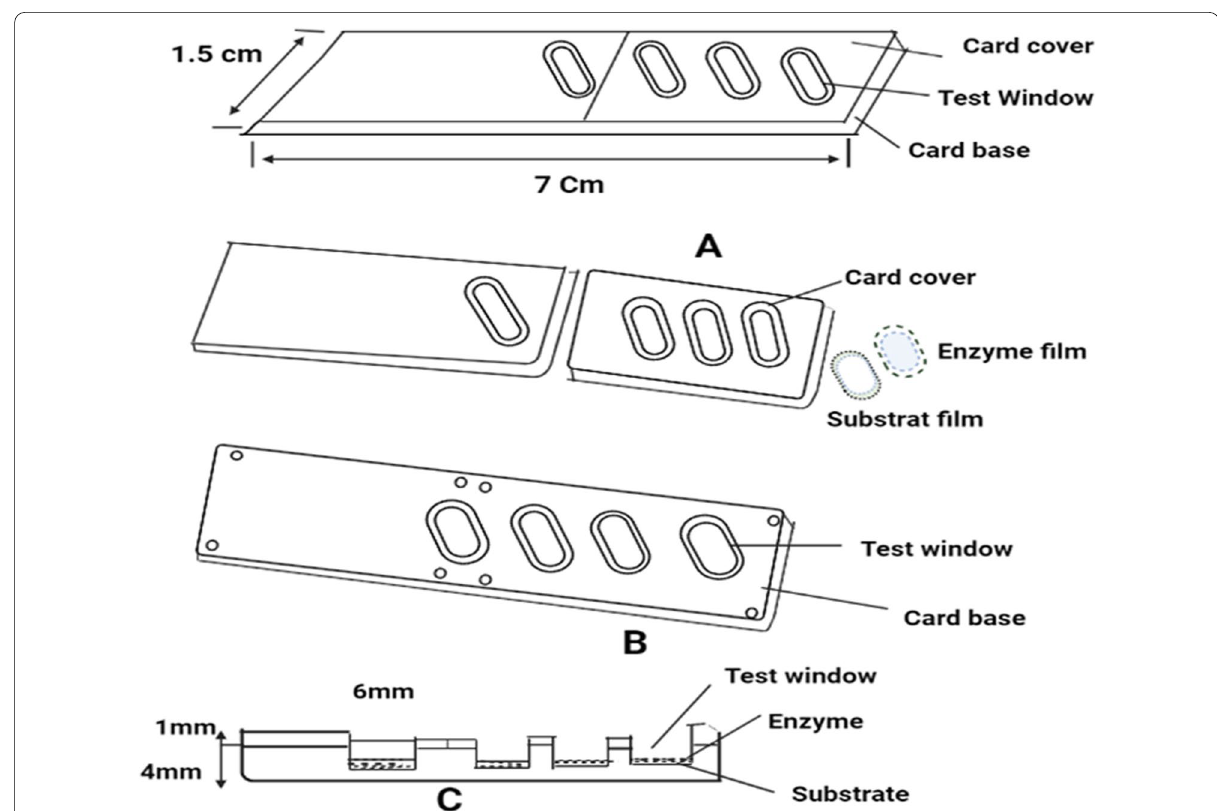
Fig. 1 Schematic illustration of the dual-film visual screening card: A panorama, B decomposition schematic, and C longitudinal